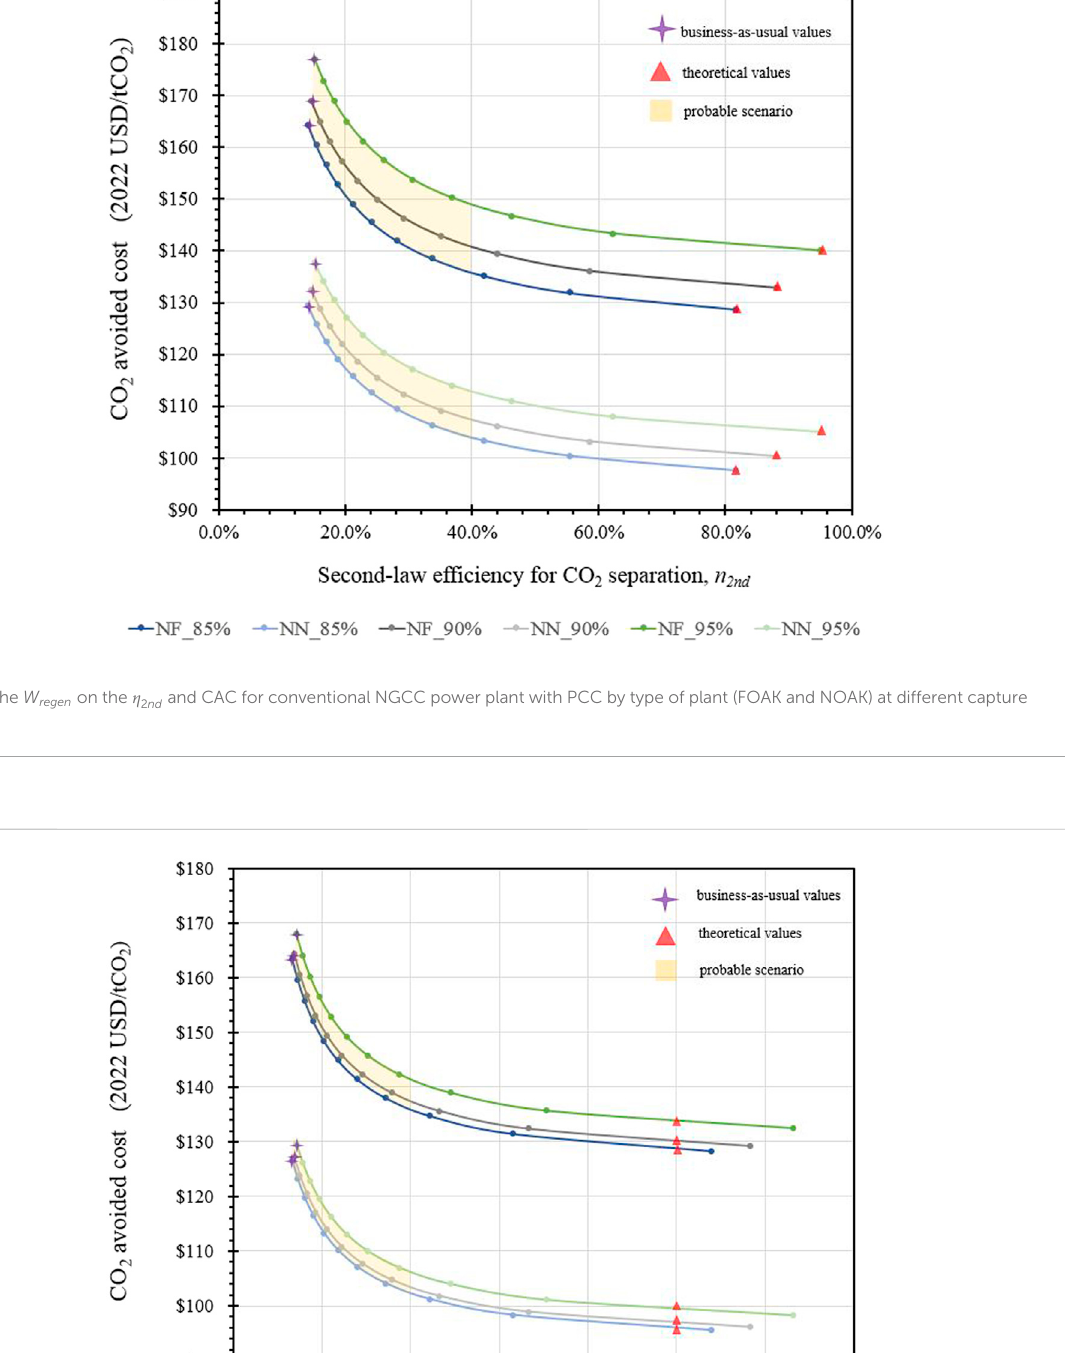
Frontiers in Energy